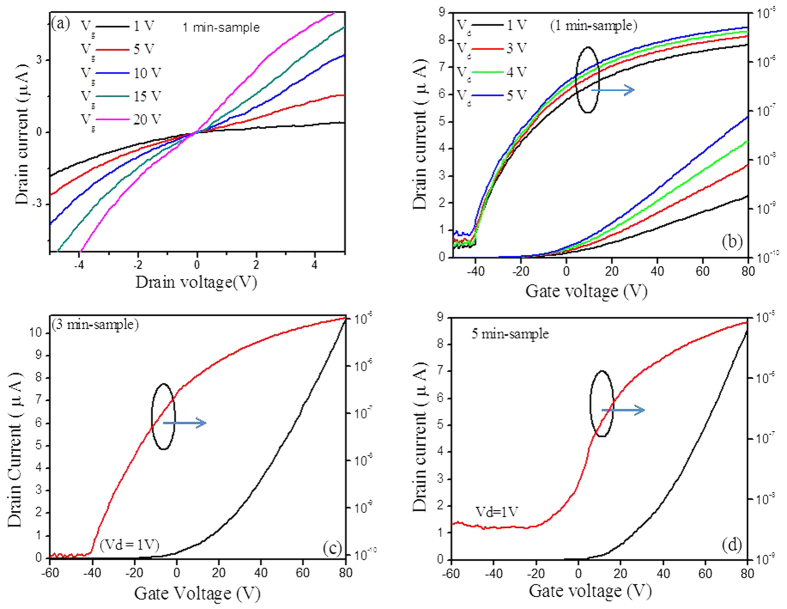
(a) Id–Vd of MoS2 FET of
1-min sample; (b) Id–Vg of
MoS2 FET (1 min-sample) at
Vd = 1, 3, 4 and 5 V; (c,d)
Id–Vg of MoS2 FETs,
3 min-sample (c), and 5 min-sample (d)
at fixed Vd = 1V.